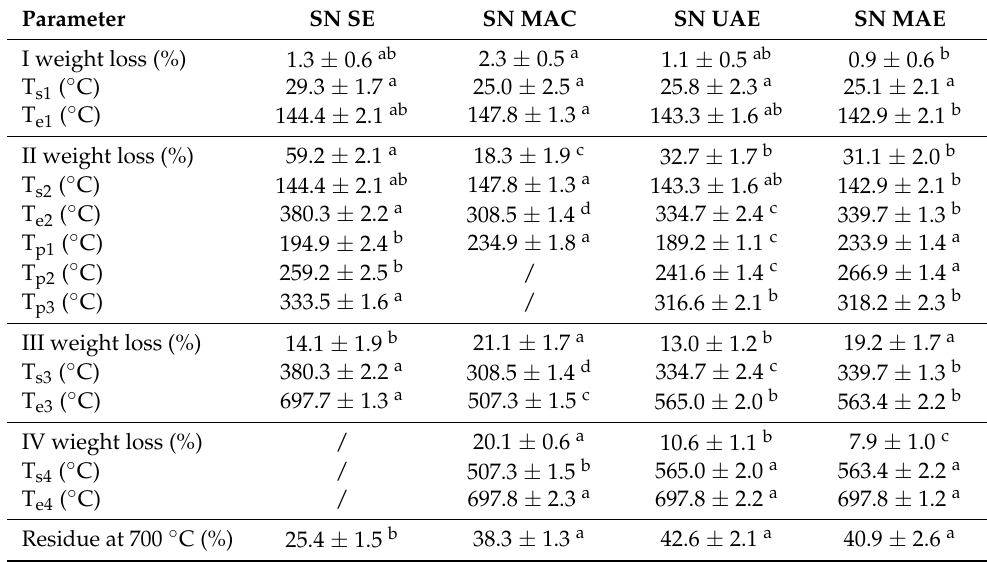
Table 3. Results of thermogravimetric analysis (TGA) of dried nettle extracts.